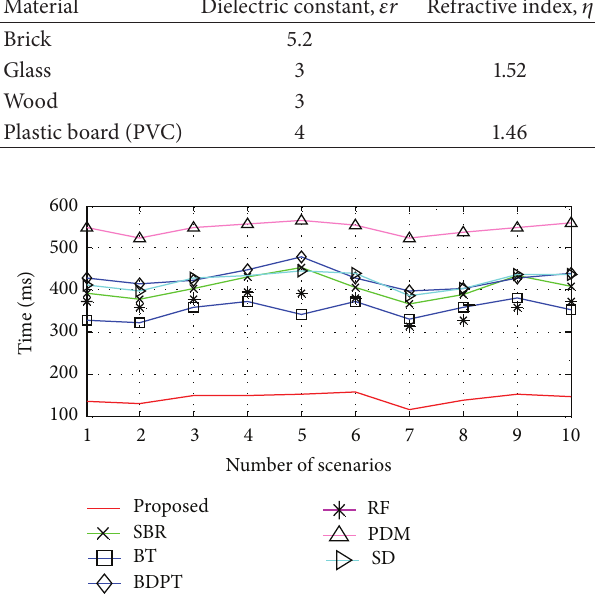
Figure 10: Comparison in terms of